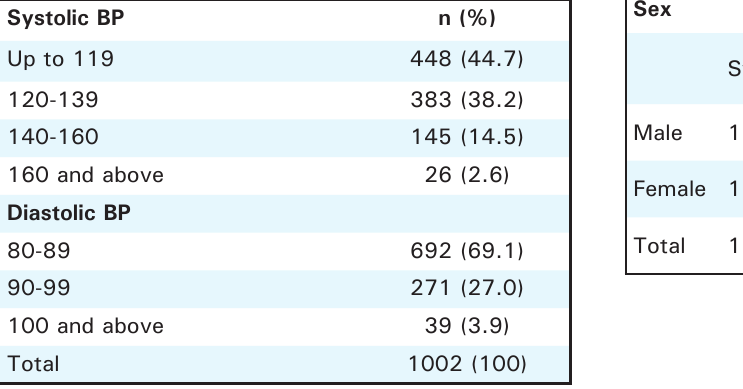
Table 3. Systolic and diastolic Blood pressure of re- spondents.